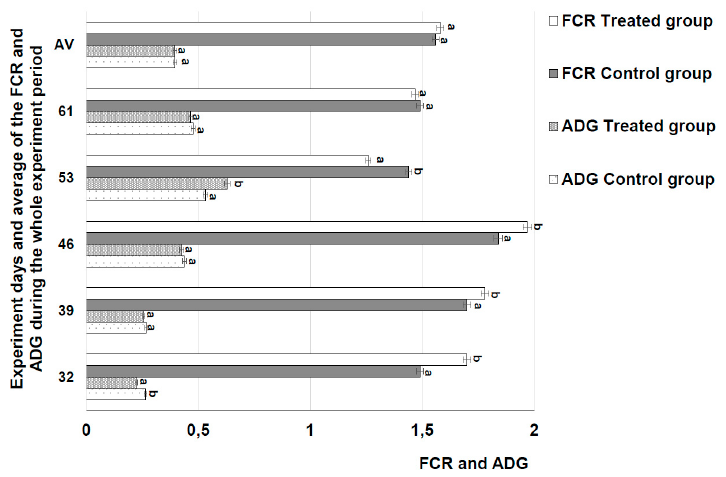
Figure 5. Average daily gain (ADG) and feed conversion ratio (FCR) of the piglets. The data are expressed as the mean ± standard deviation ( n = 100). The data were statistically compared with a paired t-test and column statistics. Means followed by different letters (a,b) are significantly different ( p ≤ 0.05).